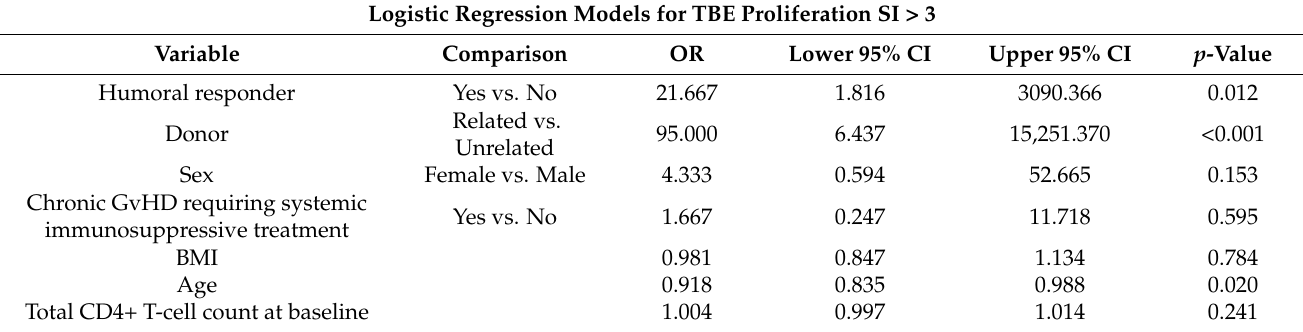
Table 2. Univariable logistic regression model with Firth correction for the dependent variable TBE proliferation with stimulation index > 3 at baseline (patients